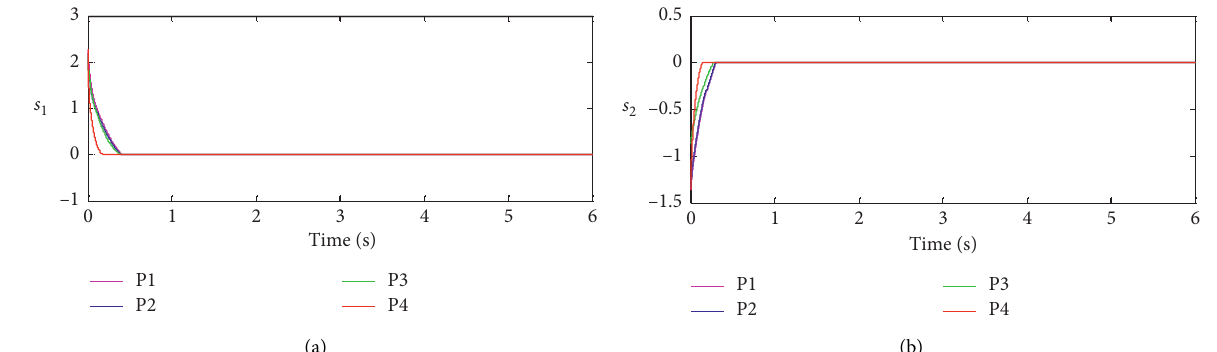
Figure 10: Sliding surfaces versus time with different